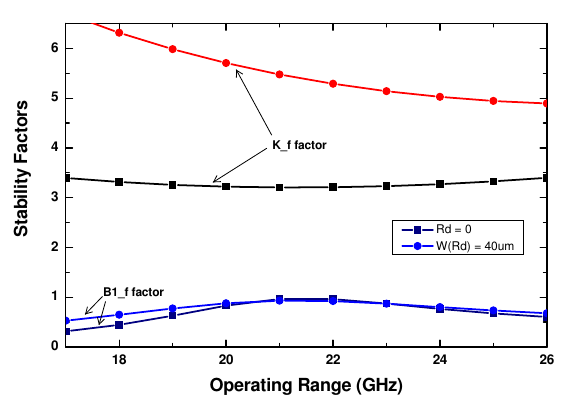
Figure 8. Upward shift in the Rollette stability factors ( K